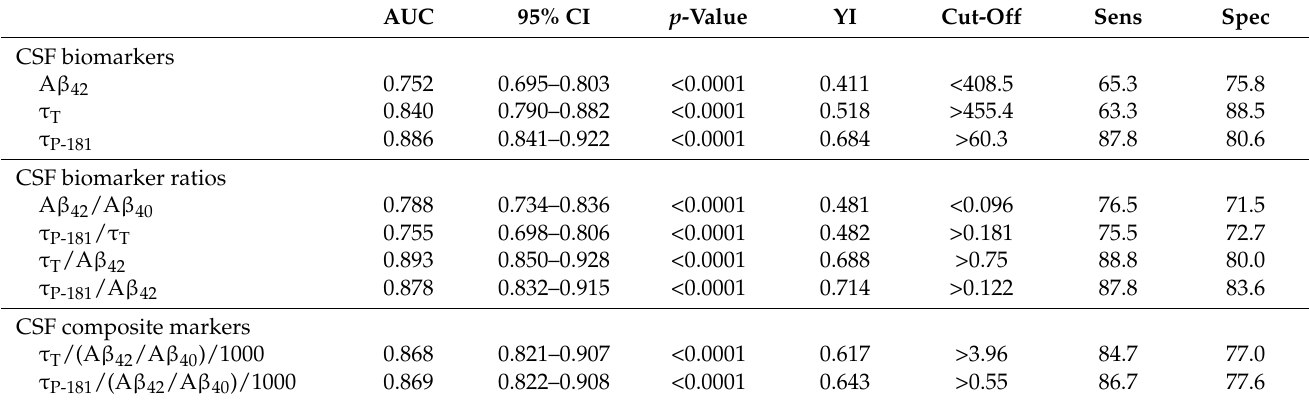
Table 2. ROC curve analysis of the diagnostic accuracy of CSF biomarkers, biomarker ratios, and com- posite markers in the differentiation of Alzheimer’s disease dementia from all other clinical syndromes and control subjects. AUC: area under the curve; 95% CI: 95% confidence interval; YI: Youden Index. AUC 95% CI p -Value YI Cut-Off Sens Spec